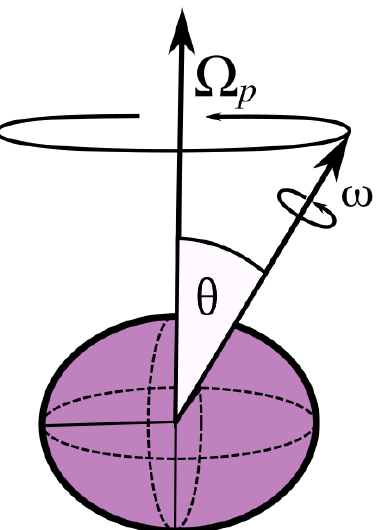
Figure 7. Schematic plot of free precession: rotational axis of the object moves around the precession axis, with the wobble angle θ and precession spin Ω p